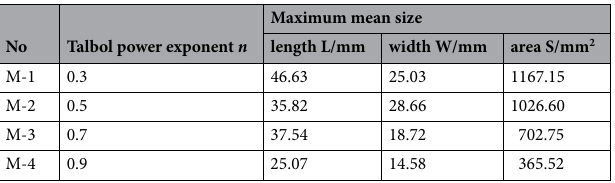
Table 6. Size of the damaged area at the bottom of the samples at all levels.